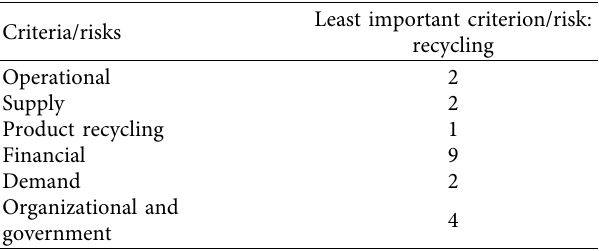
Table 5: Pairwise comparison of other criteria with the least important criterion.